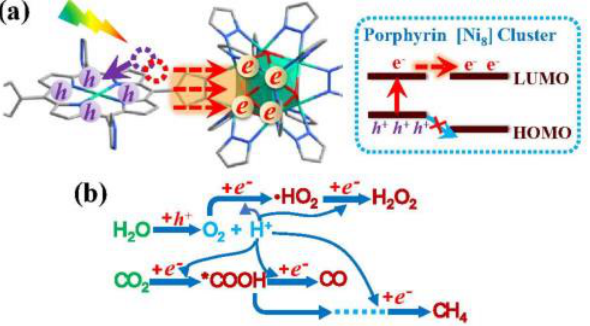
Figure 6. Proposed mechanism for CO 2 photoreduction by PCN-601 with (a) charge separation and transfer through a coordination sphere; (b) reaction pathways for the products. Reprinted with permission from Ref. [85]. 2020 Fang, Z.-B.; Liu, T.-T.; Liu, J.; Jin, S.; Wu, X.-P.; Gong, X.-Q.; Wang, K.; Yin, Q.; Liu, T.-F.; Cao,